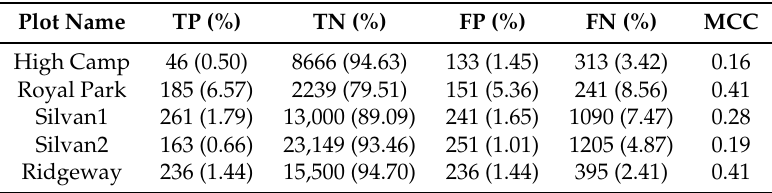
Table 5. Summary of confusion matrix results between TLS normalised point cloud and validation frame data. For each plot, True Positives (TP), True Negatives (TN), False Positives (FP), False Negatives (FN) and Matthews Correlation Coefficient (MCC) are given.